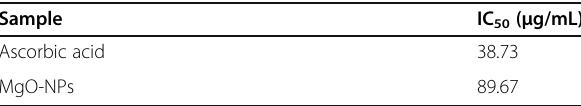
Table 1 In vitro antioxidant activity of MgO-NPs synthesized from Pterocarpus marsupium heartwood extract by DPPH radical